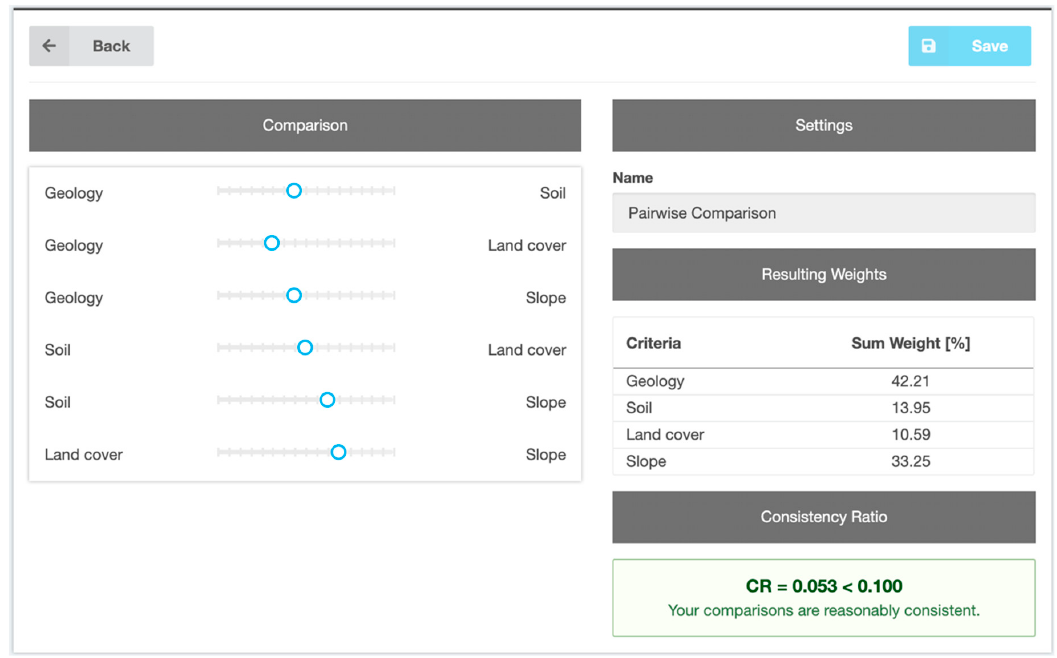
Figure 3. Interface of web GIS tool, with weight assignment tool pairwise comparison where user can set criteria preferences via sliders and indication of the robustness of the decision is given via consistency ratio.